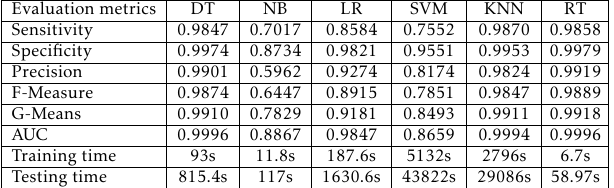
Table 3. Results of using Bagging when classifying DoS on UNSW-NB15 dataset